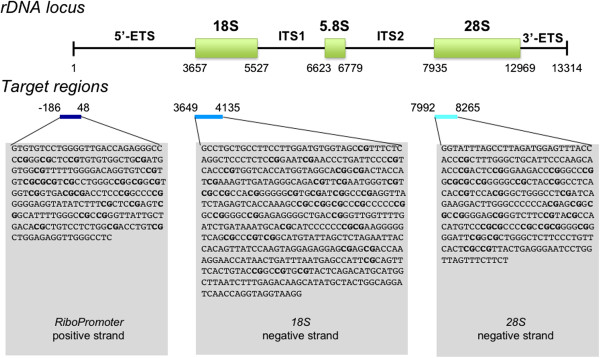
Location of the target regions selected for DNA methylation analysis within the rDNA locus. The picture reports a schematic representation of the rDNA locus and the location of the 3 target regions (RiboPromoter, 18S and 28S) that are amplified and analyzed by the MassARRAY EpiTYPER assay. Base positions are relative to the transcription starting site (+1) of rRNA primary transcript. For each amplicon the amplified strand is indicated, together with the sequence of the unconverted target region. The CpG sites whose methylation status can be assessed by the MassARRAY EpiTYPER assay are reported in bold. Abbreviations: 5’-ETS, 5’ external transcribed spacer; ITS1, Internal transcribed spacer 1; ITS2, Internal transcribed spacer 2; 3’-ETS, 3’ External transcribed spacer.